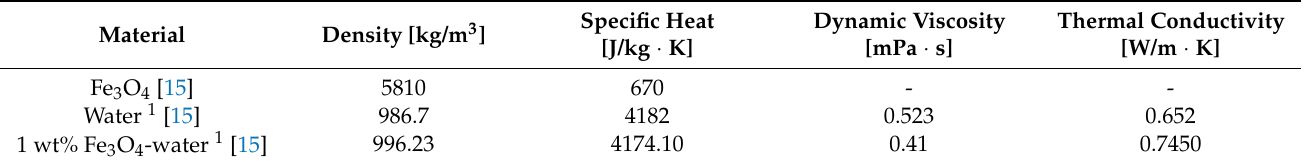
Table 1. List of relevant physical properties, including density, specific heat, dynamic viscosity, and thermal conductivity, for the nanofluid